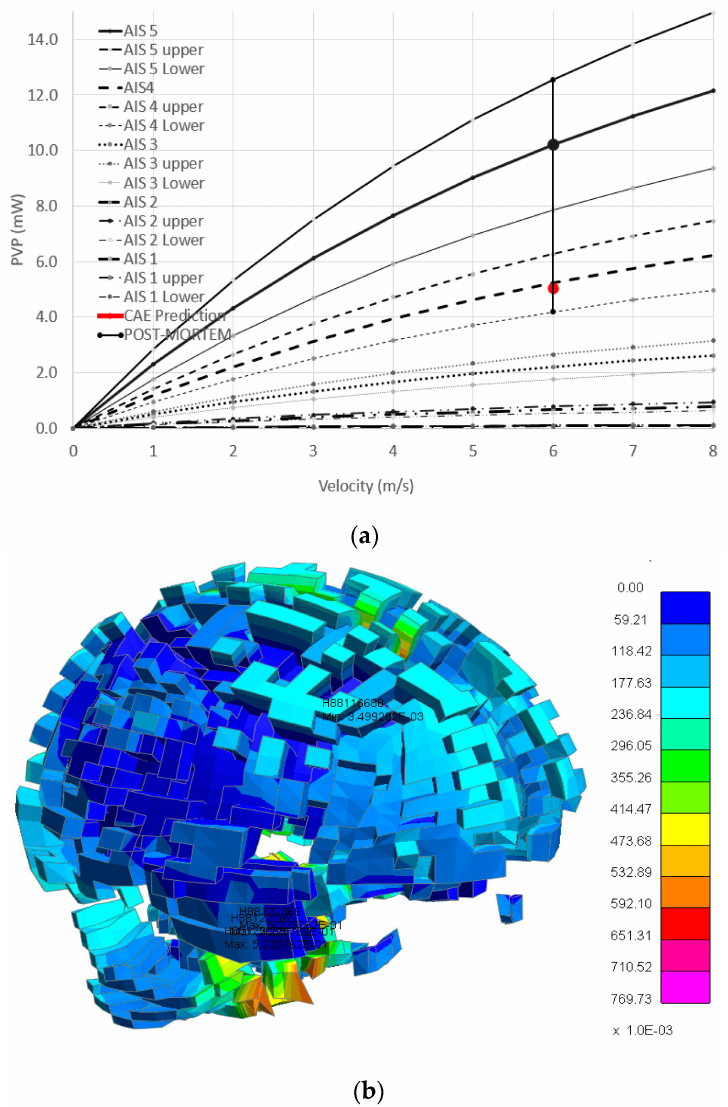
Figure 11. Occipital White Matter OTM Model. ( a ) Occipital white matter trauma prediction, ( b ) Maximum Principal strain (white